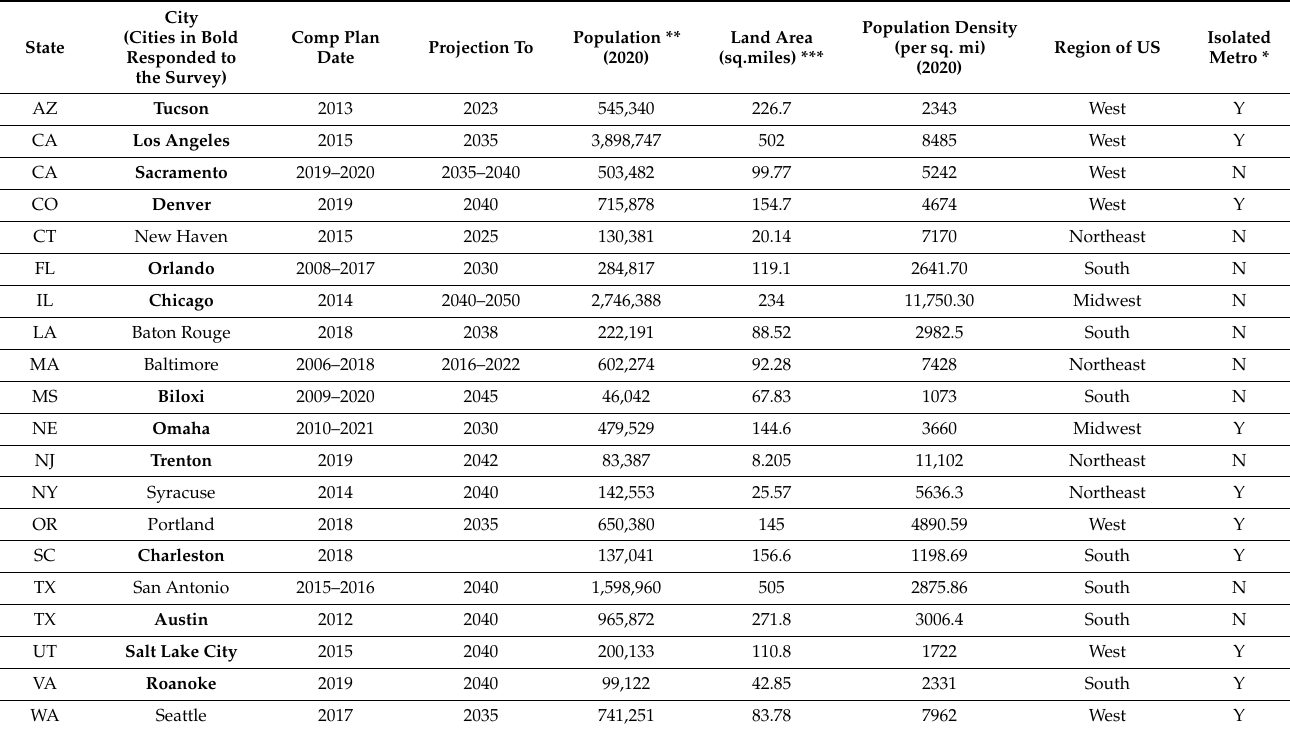
Table 1. 20 Cities identified as using a constellation of plans comprehensive plan